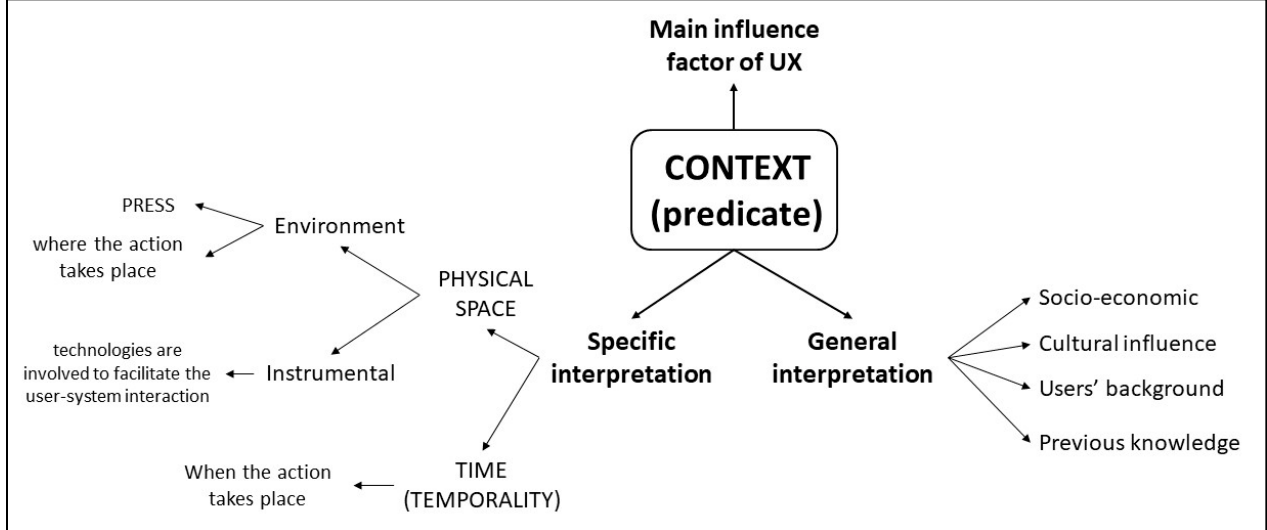
Figure 5. Graphic representation of the main interpretations of the context of use.